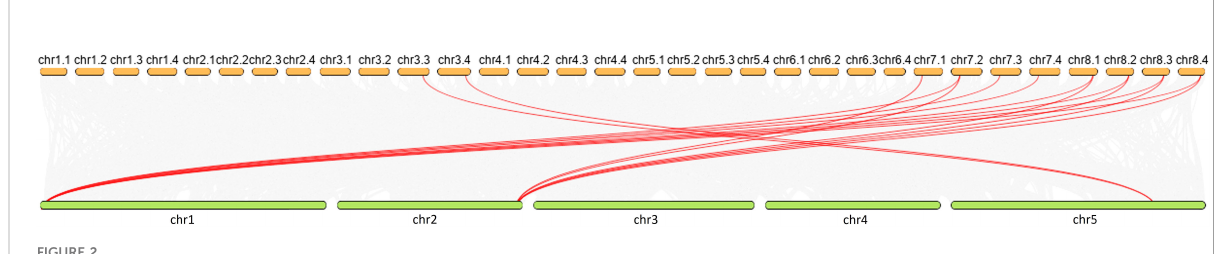
FIGURE 2 Collinearity analysis of the MsLEA_2 genes in Medicago sativa to Arabidopsis thaliana. The gray lines represent collinearity of all genes between the two species; the red line denote collinearity between LEA_2 family members in both species.